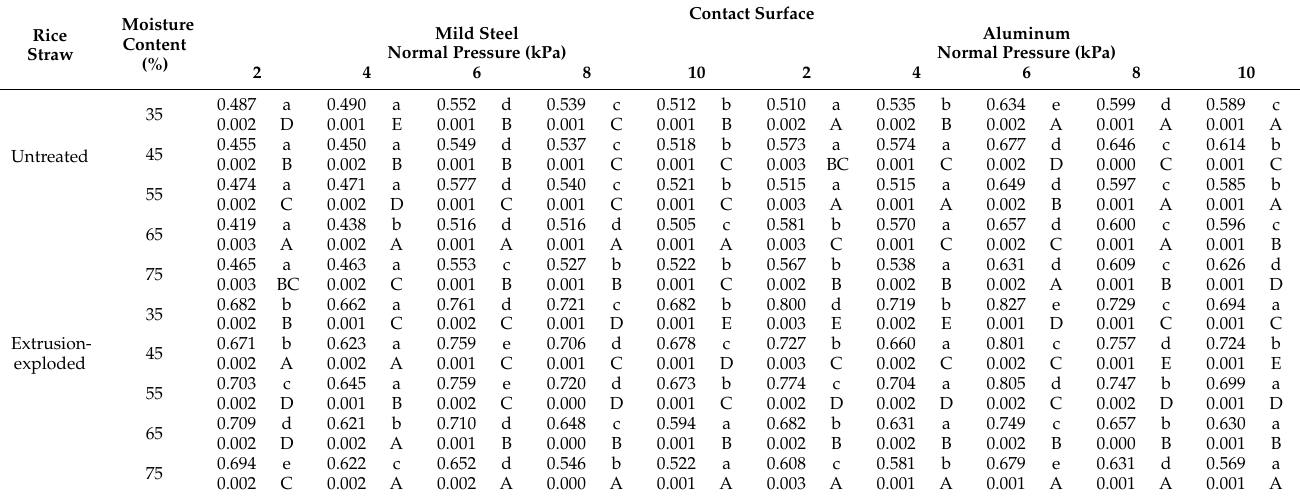
Table 3. Coefficient of sliding friction of rice straw on mild steel and an aluminum surface with different levels of moisture content and normal pressure levels.